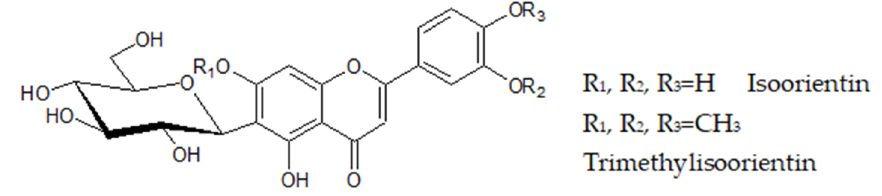
Figure 3. Isoorientin and trimethylisoorientin. Table 1. LC-MS/MS details of compounds detected in extracts and analyzed at 40eV in negative ion mode.